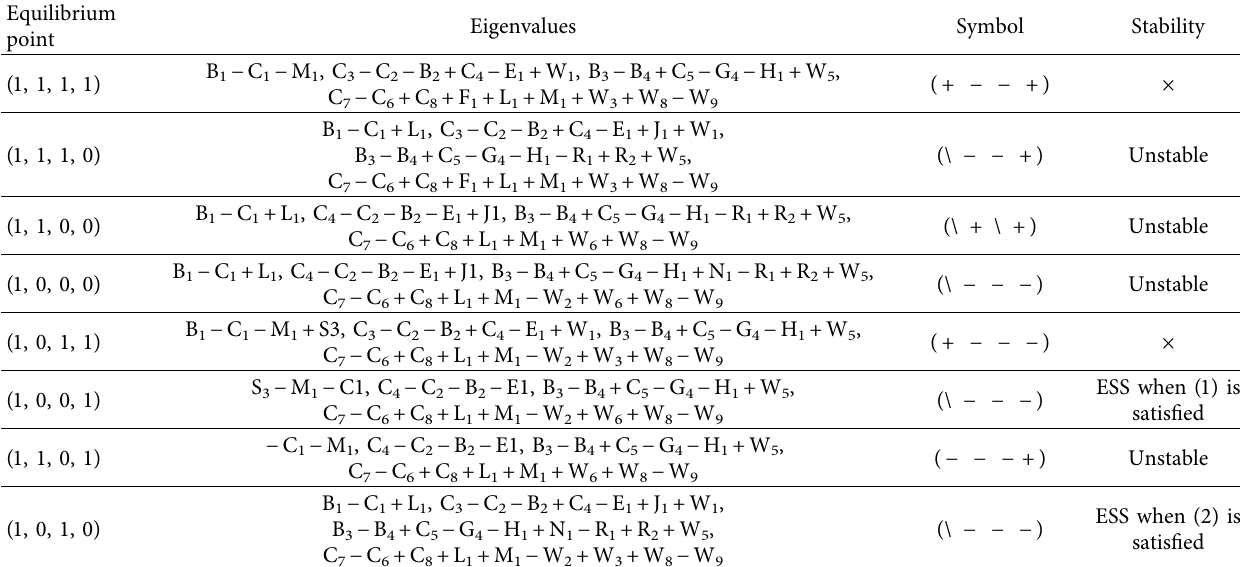
Symbol Stability